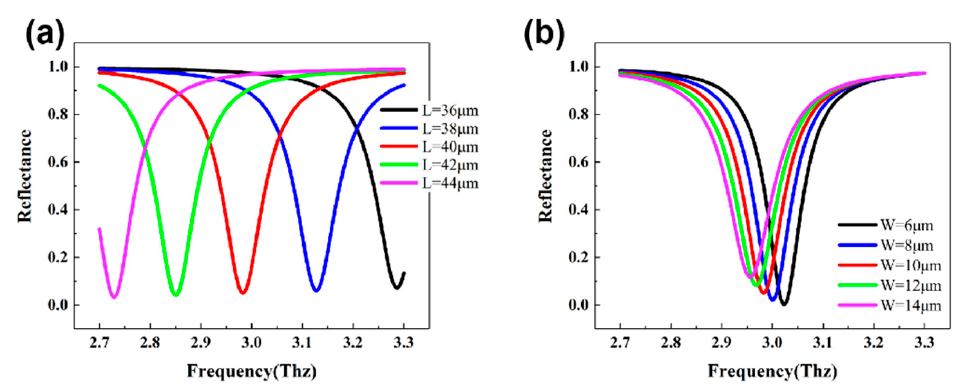
Figure 2. ( a ) The effect of resonant metal length on structure reflectivity. ( b ) The effect of resonant metal width on structure reflectivity.